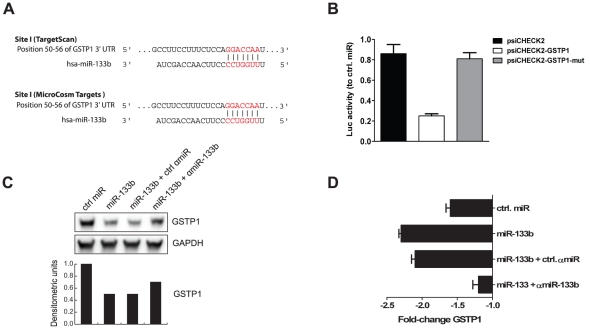
miR-133b controls expression of glutathione-S-transferase pi (GSTP1).(A) miR-133b target sites within the 3′-UTR of GSTP1 as predicted by TargetScan and MicroCosm Targets. (B) 3′-UTR targeting assay. HeLa cells were cotransfected with different combinations of miR mimics and a luciferase reporter plasmid harboring the complete 3′-UTR of GSTP1 (psiCHECK2-GSTP1) or the 3′-UTR missing the miR-133b binding site (psiCHECK2-GSTP1-mut). Template plasmid (psiCHECK2) was used as a negative and normalization control. Activity of the 3′-UTR-dependent luciferase (Renilla reniformis) was measured 48 h post-transfection and normalized for transfection efficiency to the one produced by the miR- and 3′-UTR-independent luciferase (Photinus pyralis). Error bars indicate standard deviation. (C) Western blot and densitometric analysis of GSTP1 expression. Cells were transfected with miR-133b alone or together with ctrl αmiR or a specific αmiR-133b. After 48 h, cellular protein lysates were prepared and GSTP1 expression was assessed by Western blot. GAPDH was used as an internal loading standard. Ctrl miR-transfected cells were used as a reference for densitometric quantification of protein band intensity. (D) qPCR analysis. Cells were transfected for 48 h before total RNA was isolated, reverse transcribed and analyzed by qPCR for the expression of GSTP1. HuPO was used as the housekeeping gene for internal normalization. Fold-change (FCH) values are shown relative to mock-transfected cells incubated under the same conditions. All graphs are representative of at least three independent experiments.